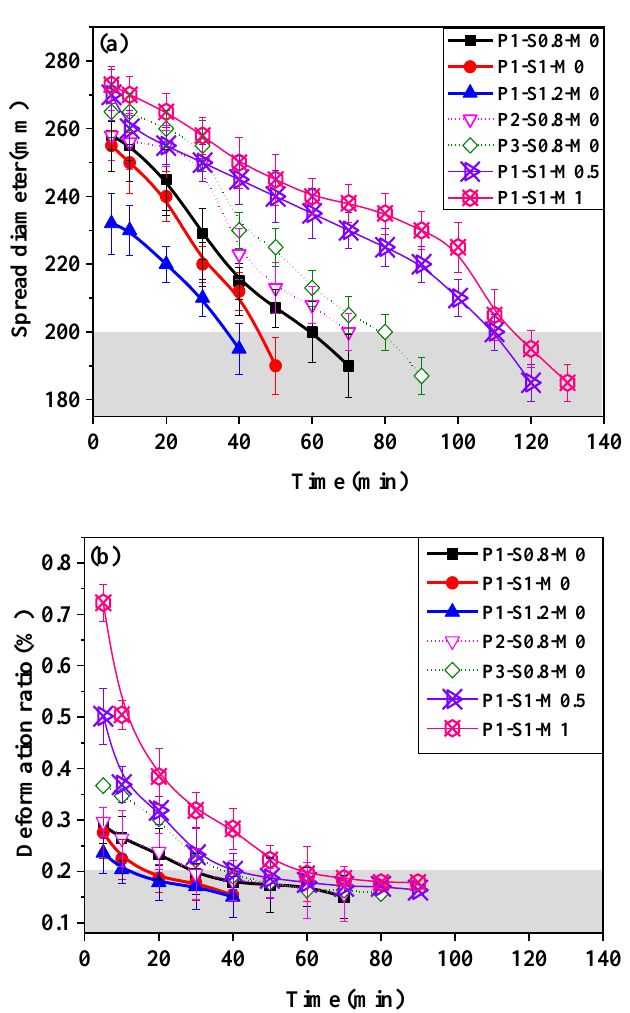
Figure 6. The change of printability of AAFS mortar with time. ( a ) Flow table test result and ( b ) buildability test result.